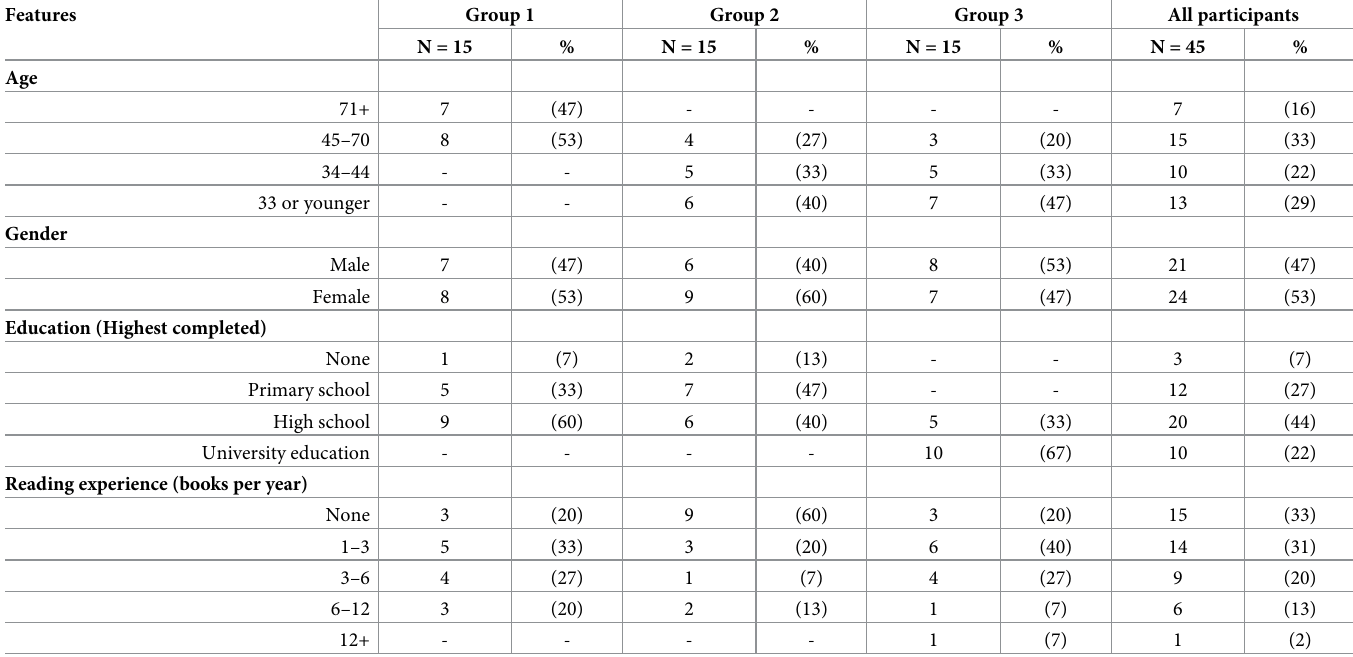
Table 5. Participant demographic information for corpus study (Group 1: Elder people, Group2: People with intellectual disabilities, Group 3: Control users).